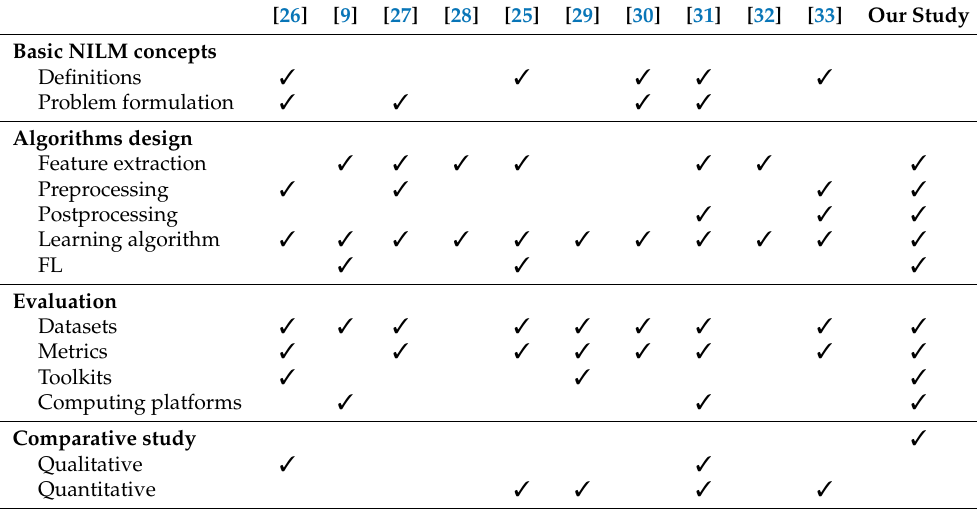
Table 1. Main concepts included in recent NILM